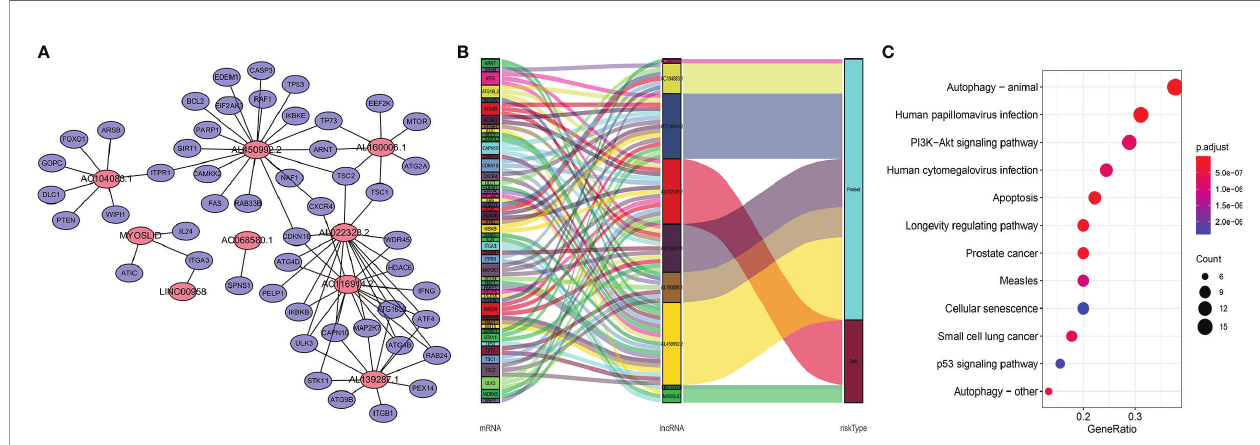
FIGURE 6 | Functional annotations of autophagic LncRNAs prognostic signature as per co-expressed mRNA. (A) Co-expressed regulatory network of LncRNAs- mRNA based on the signature. (B) Sankey diagram of co-occurrences of LncRNAs, mRNAs, and factors. (C) KEGG enrichment analysis of co-expressed mRNAs related with the LncRNA